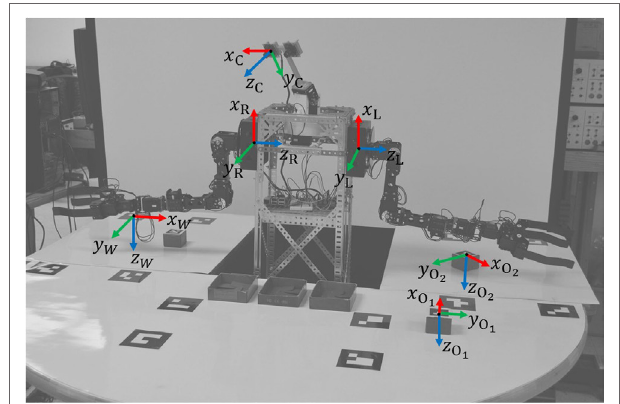
FigUre 4 | coordinate frames used by both the interface and robot to communicate spatial information .